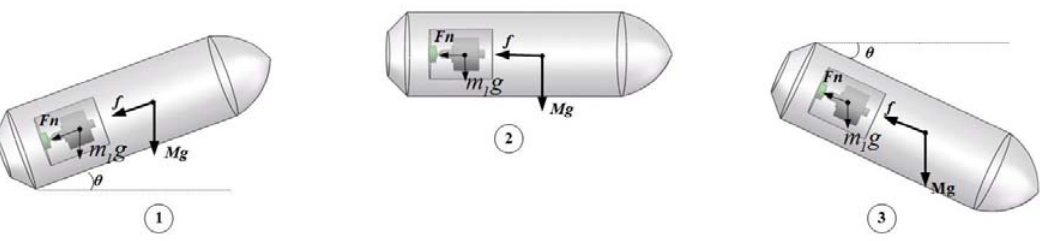
Figure 7. The analysis on affecting force in inertial free flight phase.